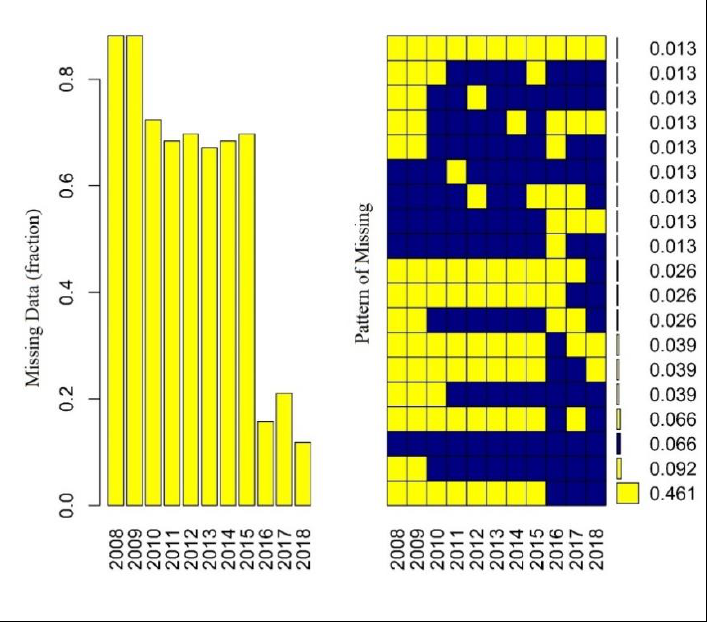
Figure 3. Visual representation of the missing monthly precipitation values from 2008 – 2018. The missing and observed (present) values are represented by yellow and navy-blue respectively.